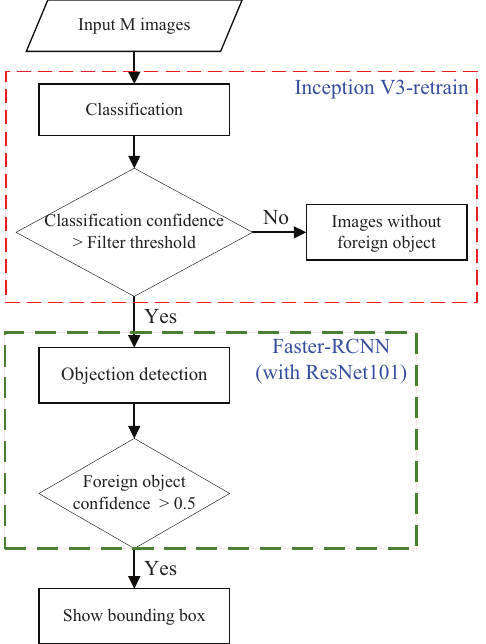
Figure 3. Two-stage foreign object detection flow